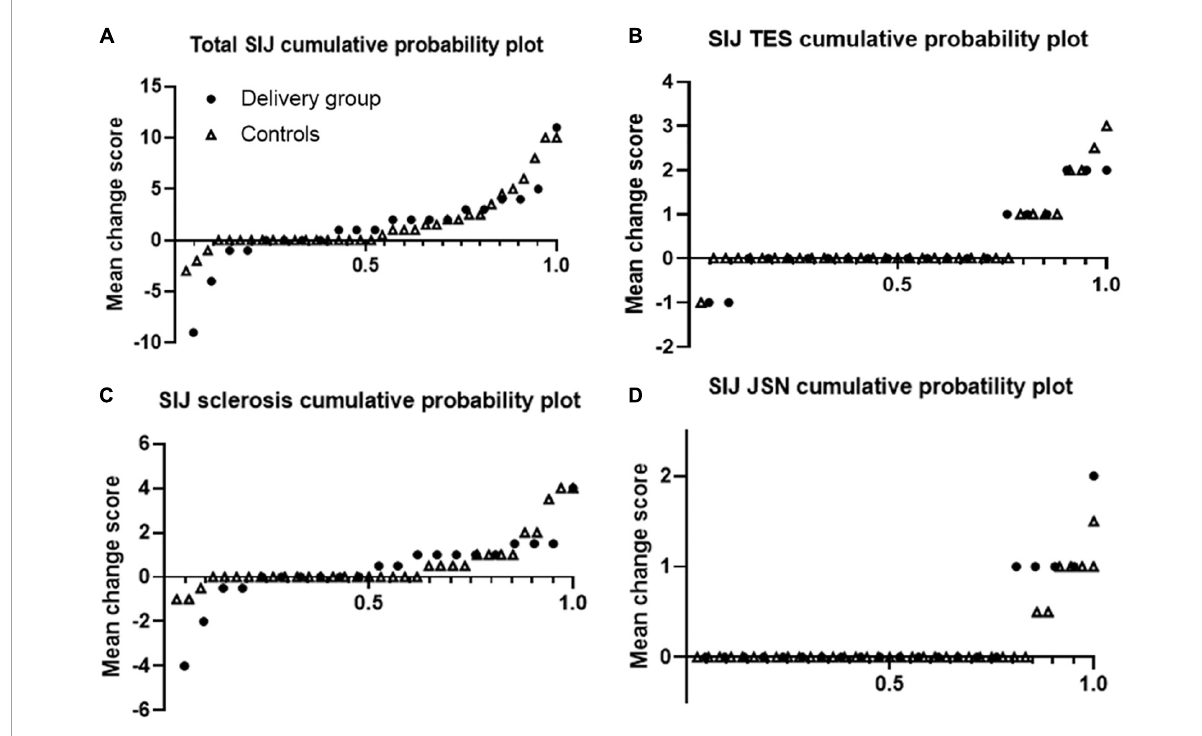
FIGURE2 Cumulative probability plots of progression of sacroiliac joints. Plots are shown for the total (A) erosion (B) , sclerosis (C) , and joint space narrowing (D) scores. Dots represents delivery group and triangle represents control